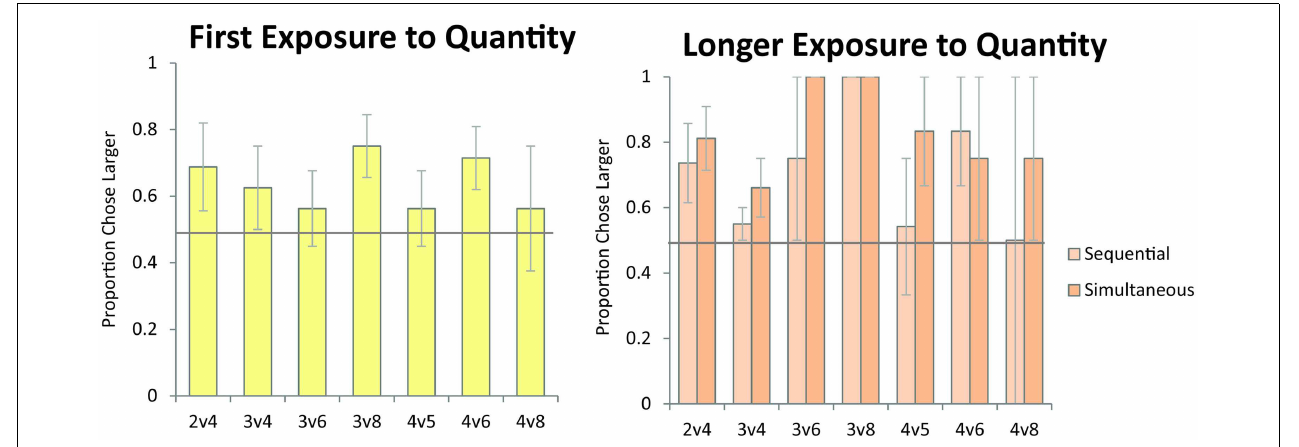
numerical discrimination (left panel, data from Experiment 1) and on longer exposure to the numerical task (right panel, data from Experiment 2) for both the sequential and simultaneous conditions. Error bars represent standard error of the mean across monkeys. Chance is a 0.5